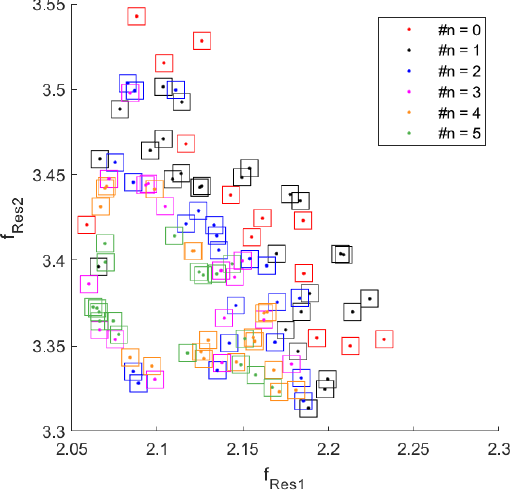
Figure 11. Regions of uncertainty classified according to the number of their intersections marked by the symbol # in the figure.